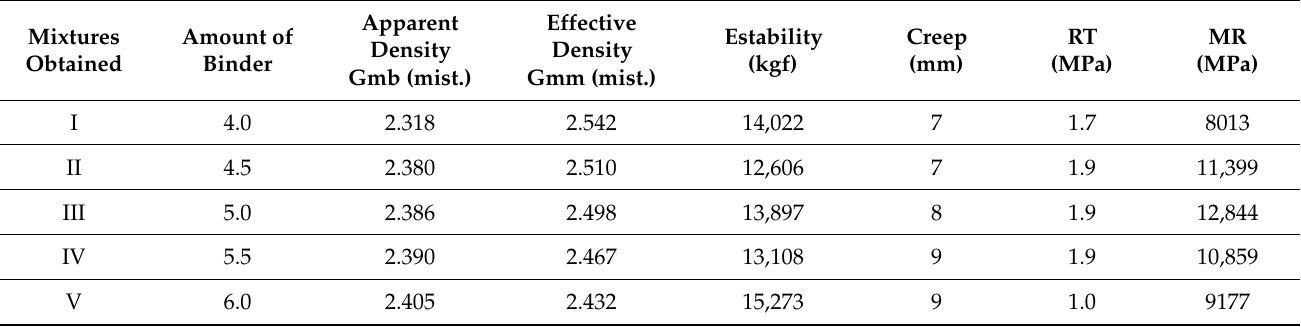
Table 3. Test bodies used by stage. Table 4. Results of Marshall dosing tests. RT represents the tensile strength, while MR is the resilient